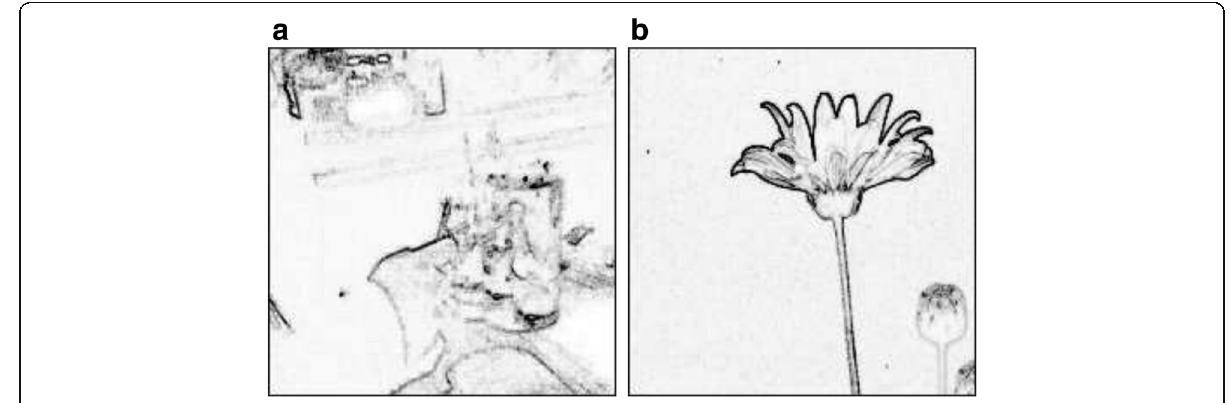
Fig. 5 Examples of different edge distributions [30]: ( a ) an amateur photo, ( b ) a professional